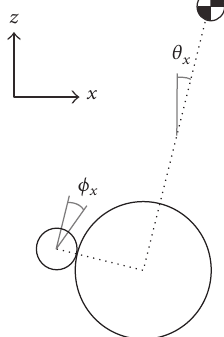
Figure 2: Generalized coordinates used in motion dynamic analysis